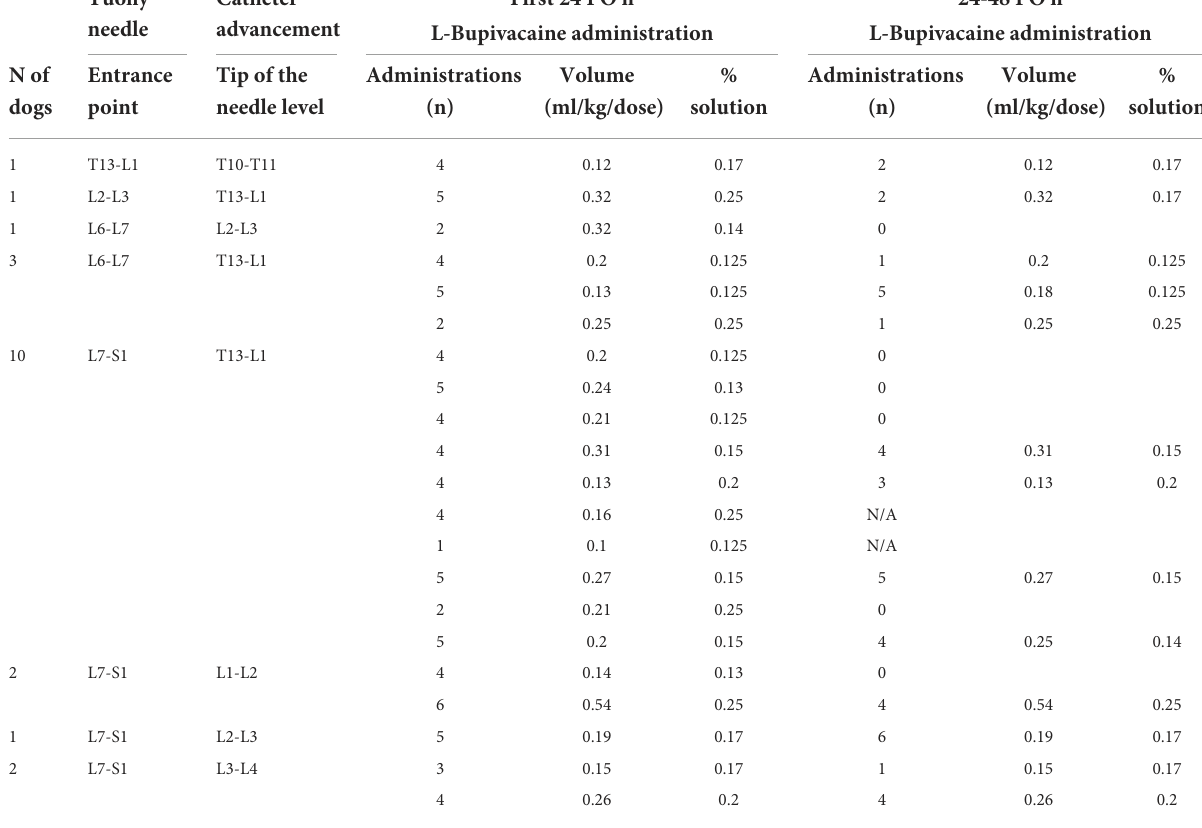
TABLE 4 Details regarding extradural catheter placement, number of postoperative administrations, volume and concentration of the L-bupivacaine used in a cohort of dogs undergoing cholecystectomy.